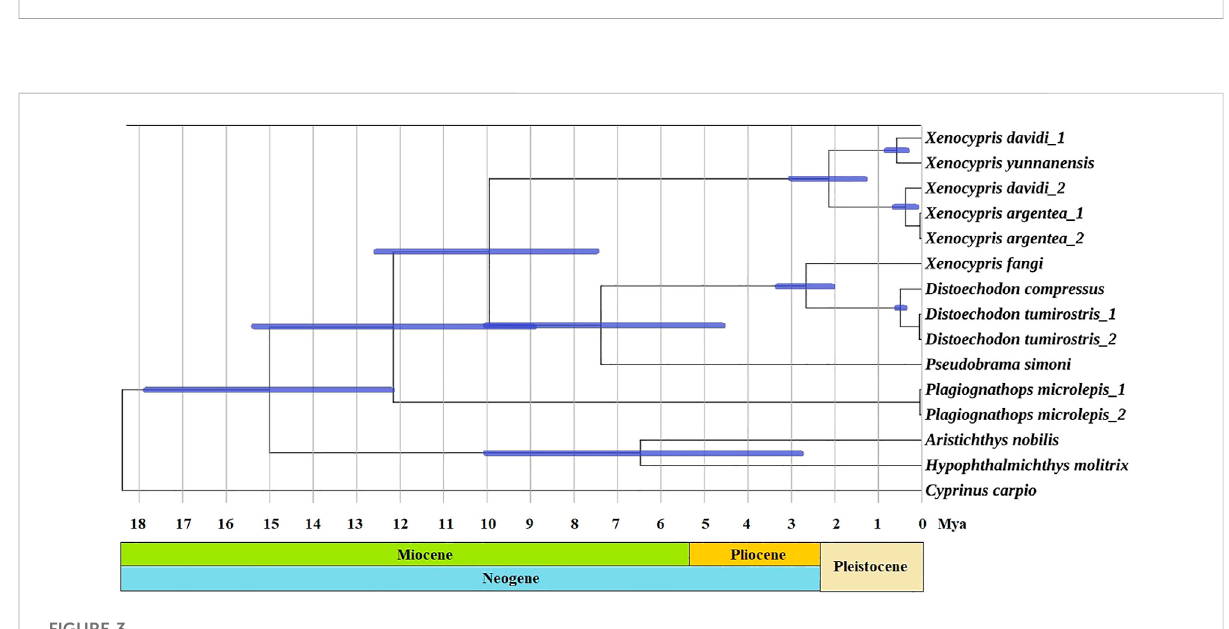
FIGURE 3 Divergence time estimation of Xenocyprinae utilized two fossil clocks in BEAST based on the best-scoring maximum-likelihood tree. Note: Node bars show 95% CI s of the divergence time